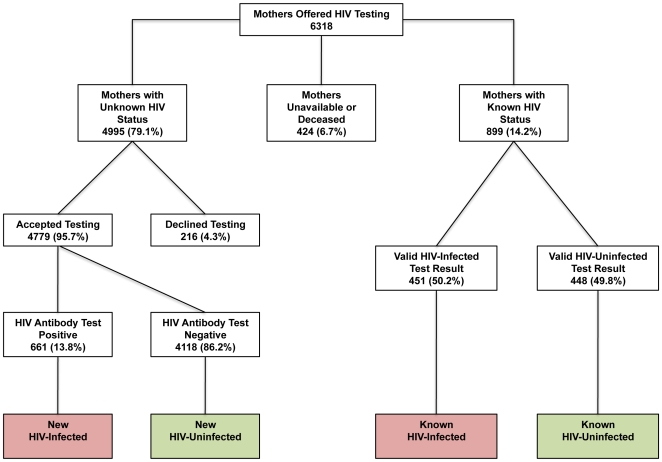
Maternal PITC Overview at Kamuzu Central Hospital; January 1-December 31, 2008.Total HIV-infected mothers (red boxes): 1112/5678 (19.6%); total HIV-uninfected mothers (green boxes): 4566/5678 (80.4%).